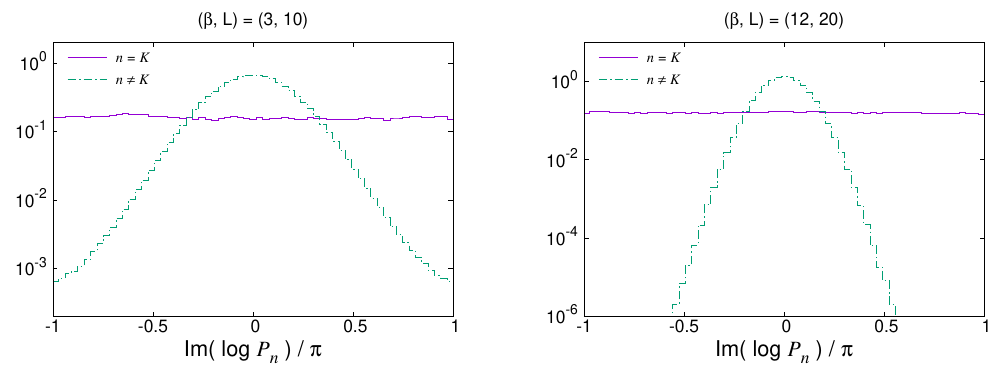
Figure 8 . The distribution of the phase of the plaquettes is plotted for the punctured model with the log de(cid:12)nition (2.11) of the topological charge for ( (cid:12); L ) = (3 ; 10) (Left) and ( (cid:12); L ) = (12 ; 20) (Right) with (cid:18) = (cid:25) . We show the results for the plaquette ( n = K ) removed from the action and those for all the other plaquettes ( n = K ) 6